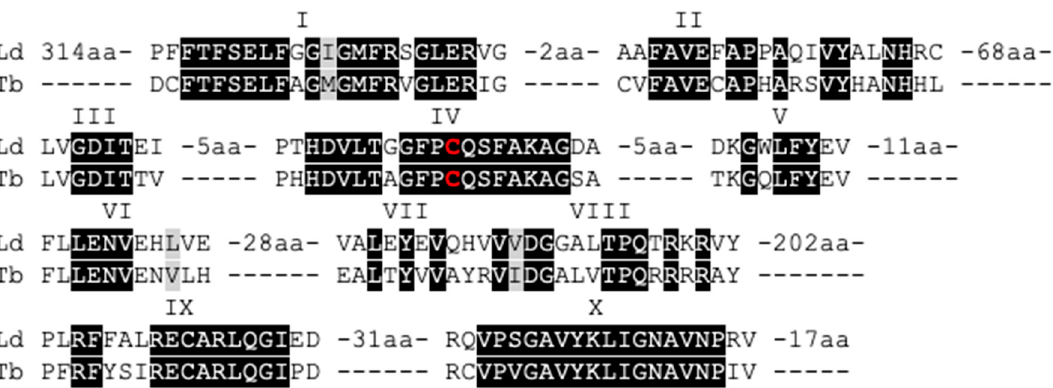
Figure 1. Protein alignment of LdDNMT (LdBPK_251230) and TbDNMT generated with T-coffee, picturing the similarities between the 10 homologous domains of C5 DNA methyltransferases. Black highlights homology, and the red character displays the position of the catalytic cysteine residue.